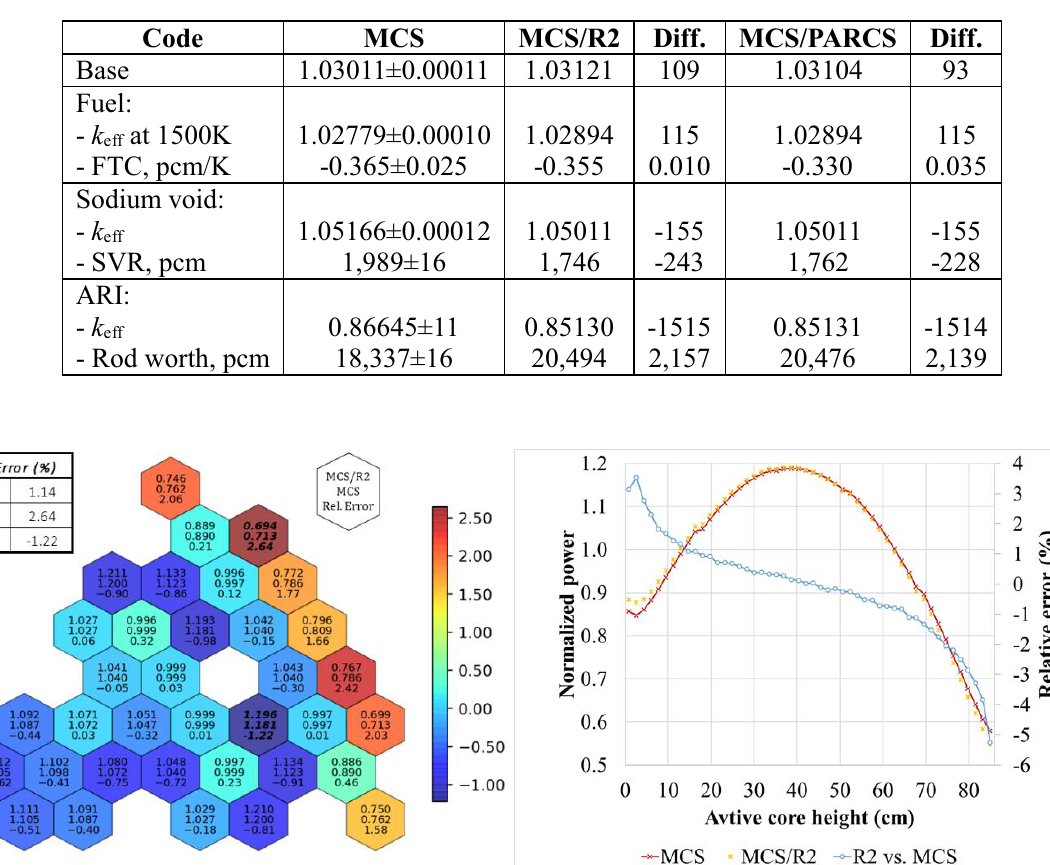
Table IV. Summary of k